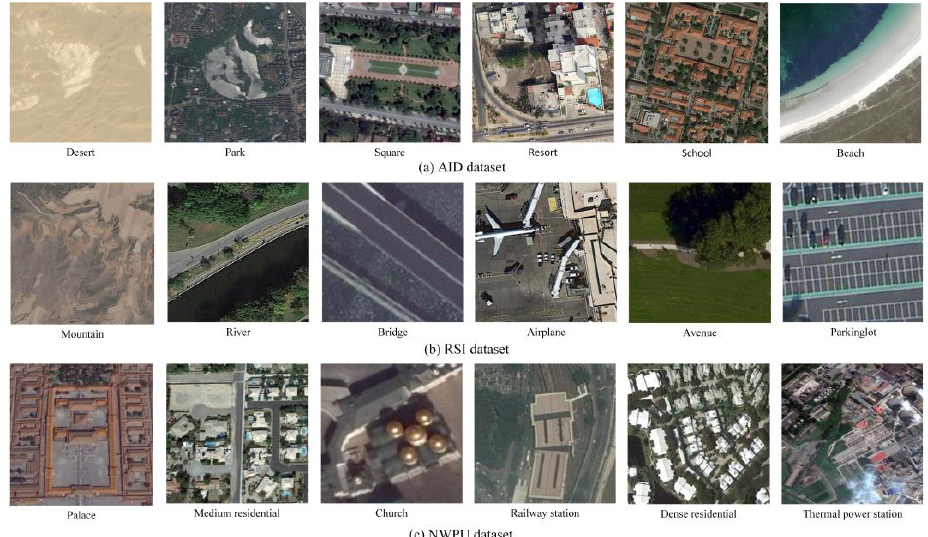
Figure 11. Misclassified samples of AID, RSI and NWPU datasets on third step task. ( a ) represents the misclassified category in the AID dataset, ( b ) represent the misclassified scenes in the RSI dataset, ( c ) indicates the misclassified category in NWPU datasest.